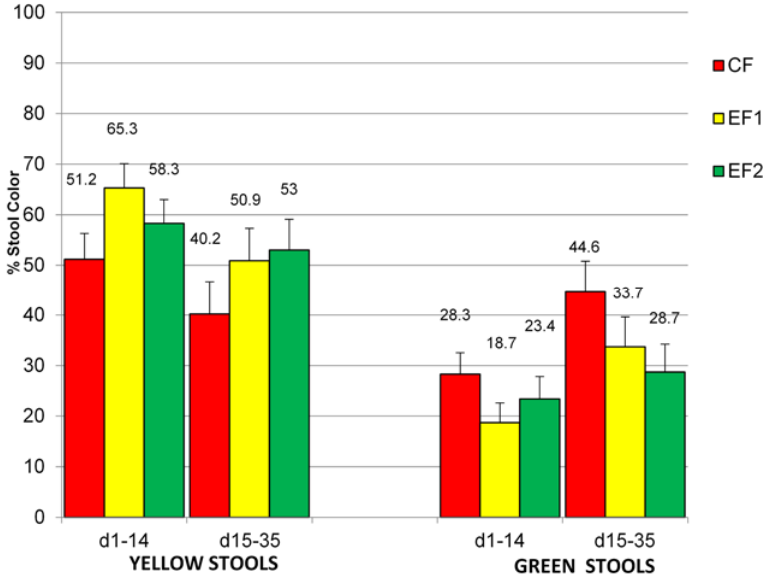
Figure 2. Percentages of yellow or green stools produced by evaluable (EV)